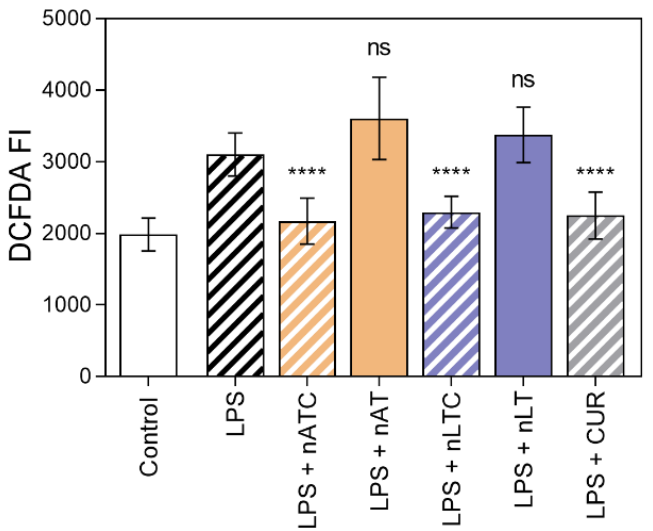
Figure 9. Inhibition of ROS on THP-1cells activated with LPS by nATC, nLTC, or CUR at 5 µg CUR/mL. Values were analysed using a one-way ANOVA compared with cells activated with LPS, **** p < 0.0001.